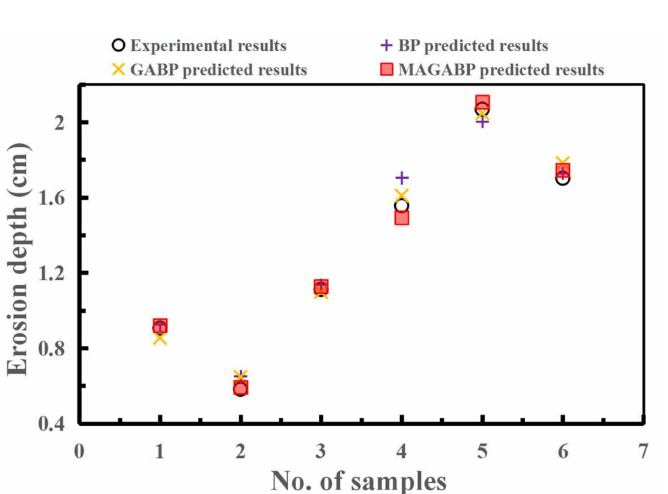
Figure 10. Comparison prediction results of di ff erent models with experimental values.